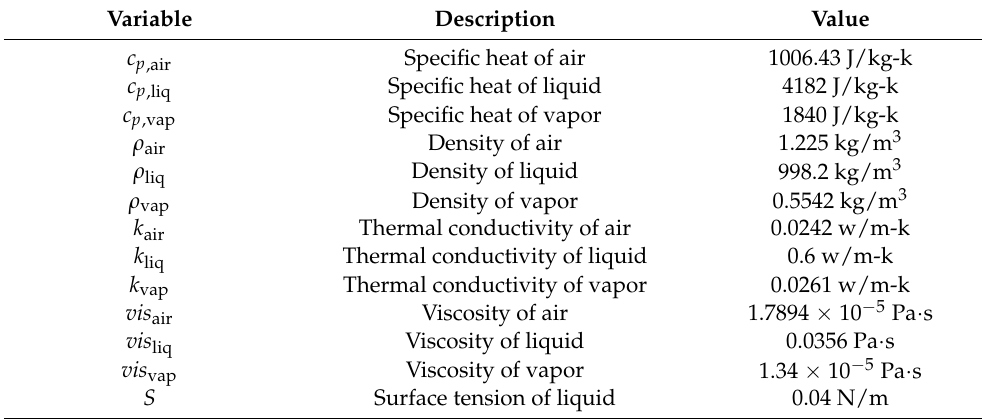
Table 2. Material